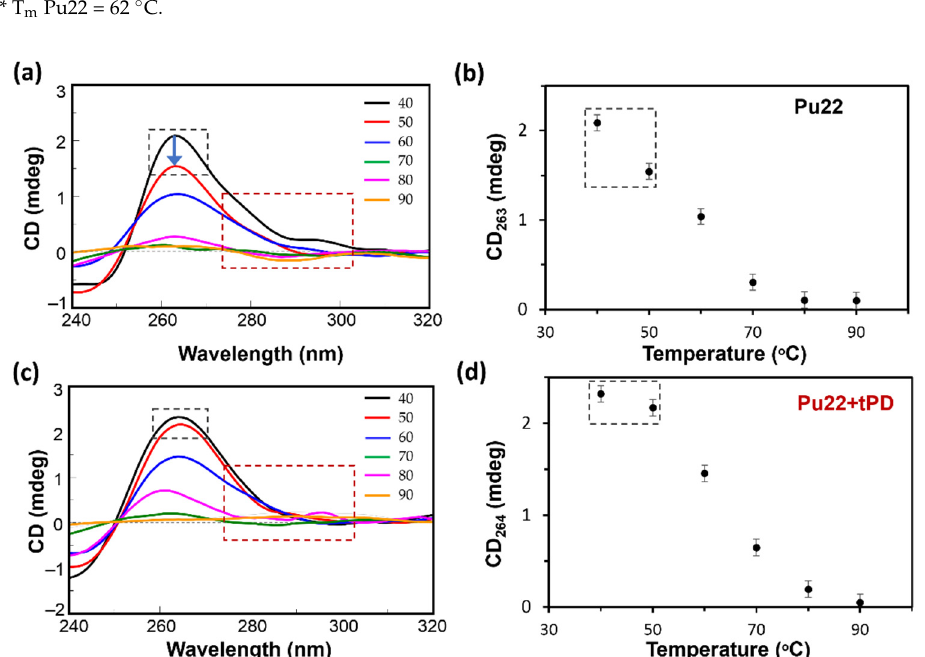
Figure 2. CD spectra of Pu22 (2.5 μ M) ( a ) and its complex with tPD ( c ) recorded in the 40–90 °C temperature range. Plots of the CD signal at λ max (in mdeg) vs. temperature (in °C) for Pu22 ( b ) and its complex with tPD ( d ) derived from panels a and c . All experiments were run in PBS, pH 7.4 (optical path length = 0.1 cm). Table 1. Summary of the CD and CD melting data for Pu22 and the complex tPD-Pu22. Δ T m is the variation in the melting temperature of the complex with respect to the Pu22 reference; Δ CD max 40–90 is the difference in the CD value at the λ max between 40 (folded state) and 90 °C (unfolded), whereas Δ CD max 40–50 is the one between 40 and 50 °C.